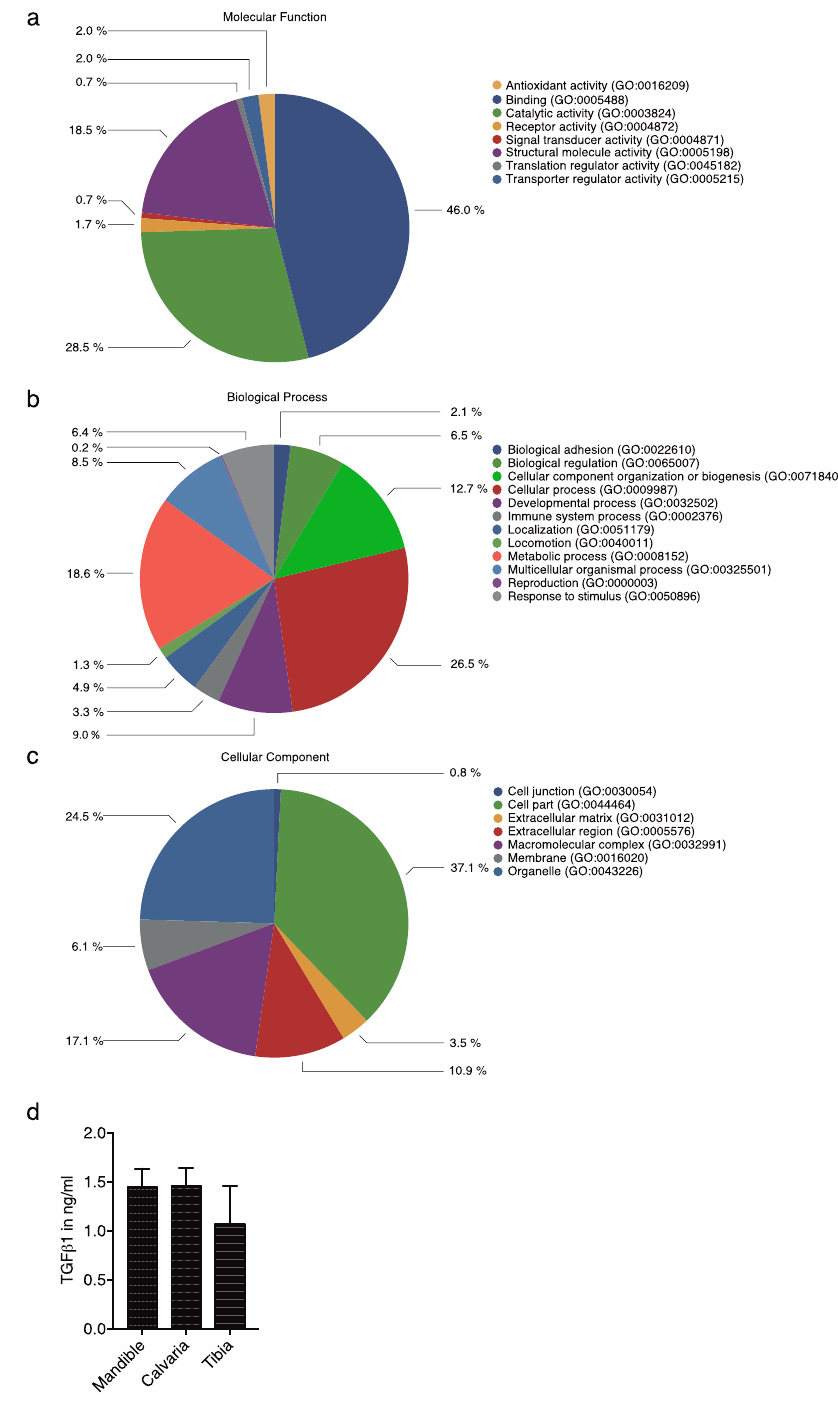
Figure 1. Acid bone lysate (ABL) contains a large spectrum of proteins including TGF- β . Panther analysis of molecular function ( a ) cellular component ( b ) and class ( c ) of proteins in ABL. ( d ) TGF - β 1 immunoassay of different bone regions: mandible, calvaria and tibia. N = 3–5. Data represent the mean ±